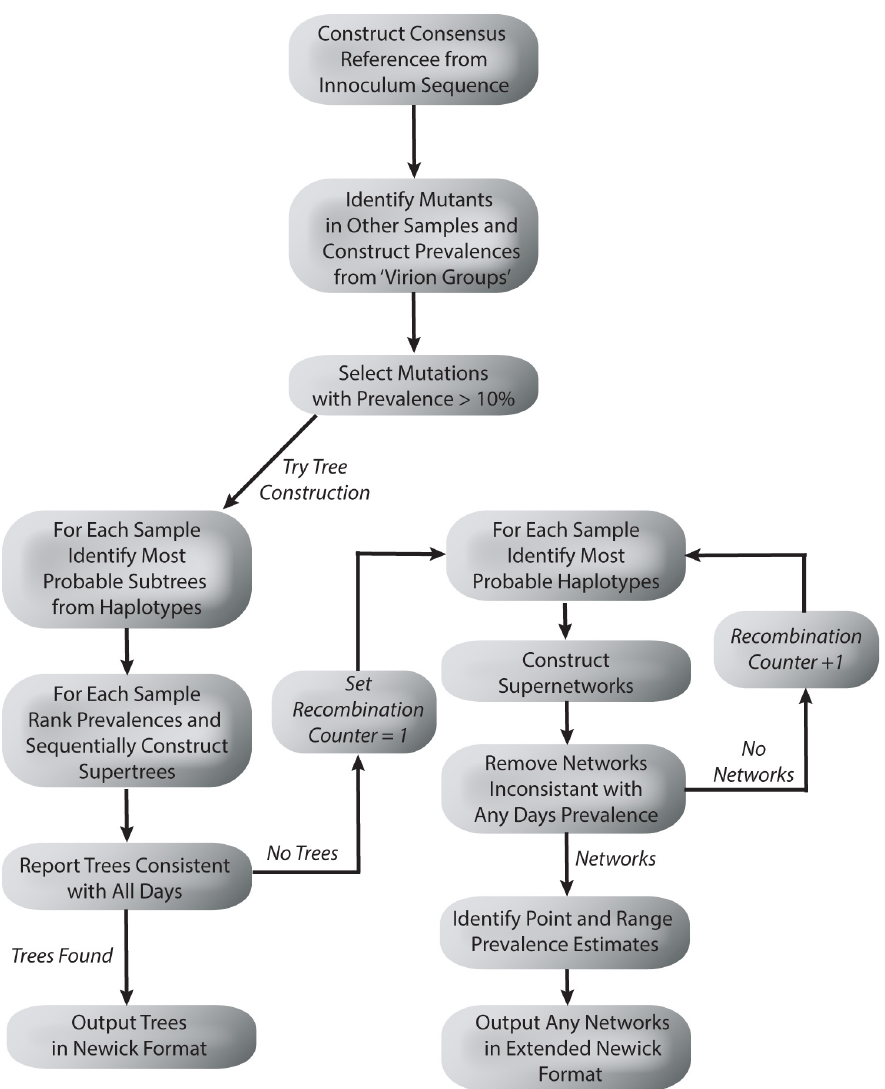
Fig 1. A flow chart describing the tree and network construction